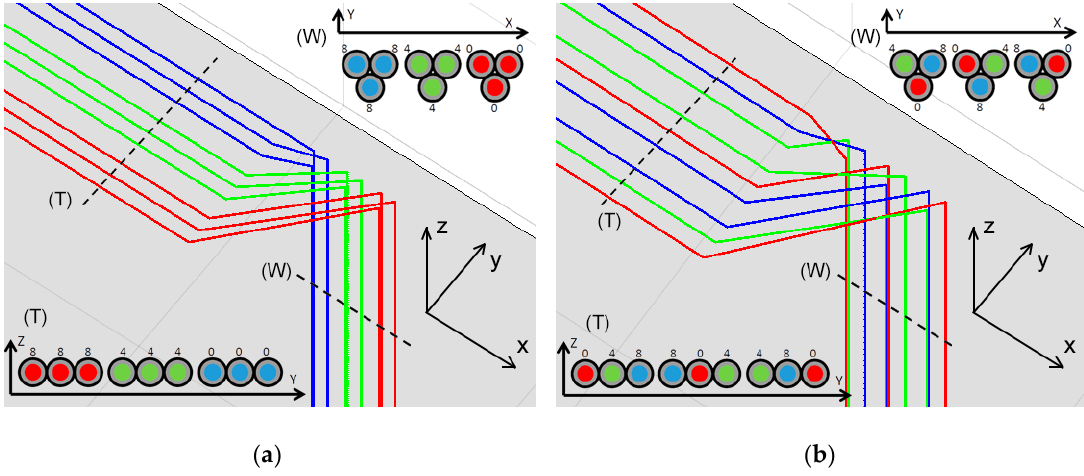
Figure 11. Original conductors’ layout (left) and the proposed alternative (right). This is the detail A of Figure 10 for both alternatives. The axes directions are indicated in the figure.